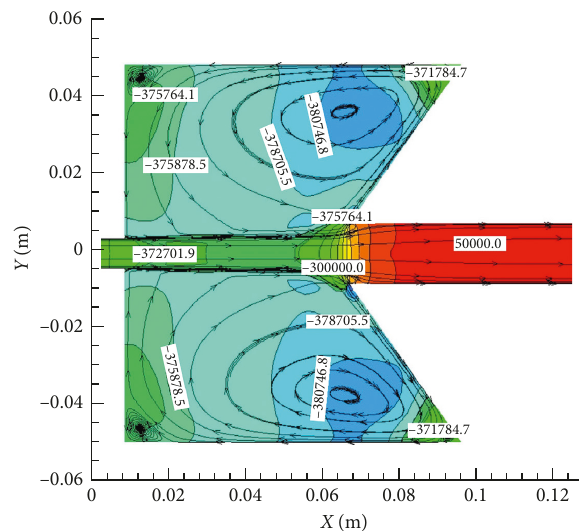
Figure 7: Time-averaged pressure nephogram before